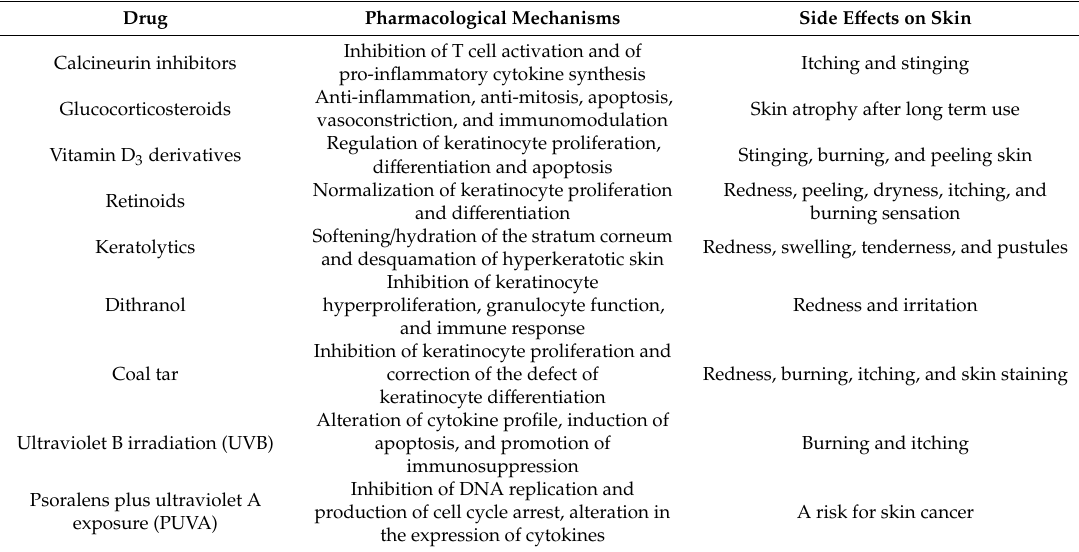
Table 1. Current topical drug therapy for psoriasis